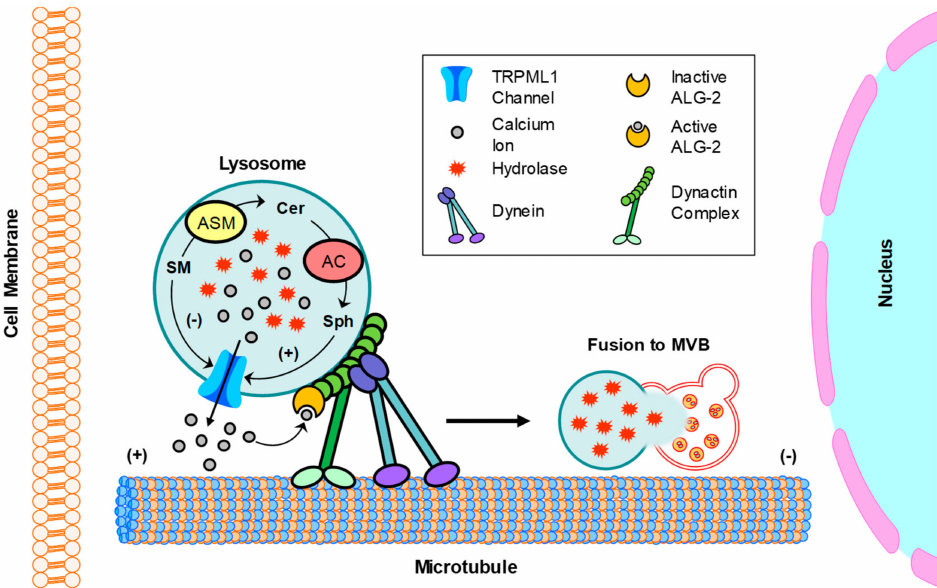
Figure 4. Regulation of lysosome tra ffi cking by sphingolipids in podocytes. Dynein-mediated retrograde transport of lysosomes promotes their fusion with MVB. This transport is dependent on the TRPML1 channel-mediated Ca 2 + release. In the lysosome, ASM converts SM into CER and AC converts CER to Sph. These sphingolipids, SM, Cer, and Sph had di ff erent e ff ects on TRPML1 channel activity in podocytes, with inhibition by SM, no e ff ect from Cer, but enhancement by Sph. SM, sphingomyelin; Cer; ceramide; Sph,